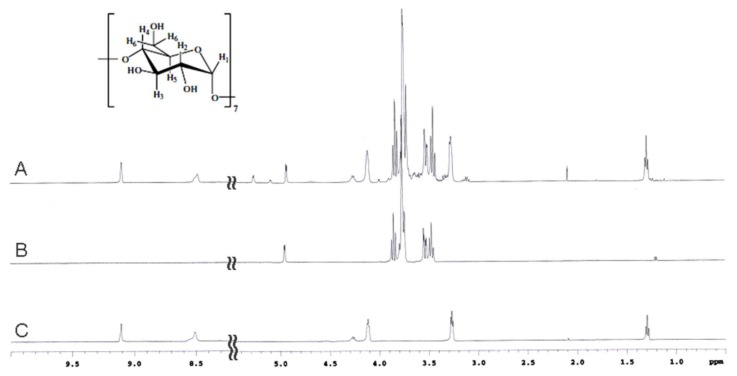
The 1H NMR spectra of HPPA:β-CD kneading product (A), β-CD (B) and HPPA (C).